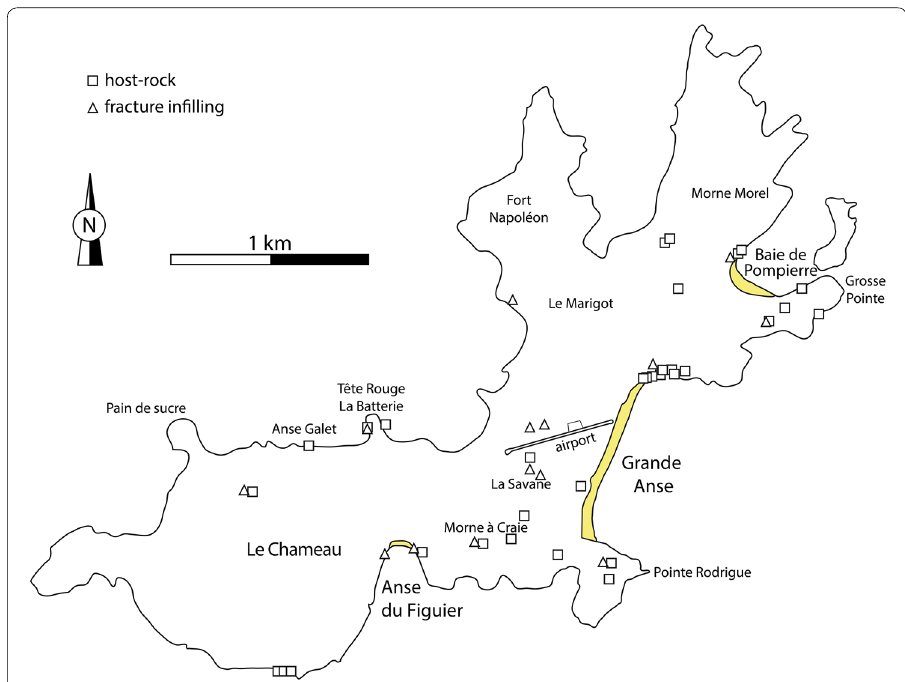
Fig. 2 Location map of the 47 samples studied. More accurate location is also provided in Table 1. Samples were extracted mainly from the 2.4 to 2.1 Ma old